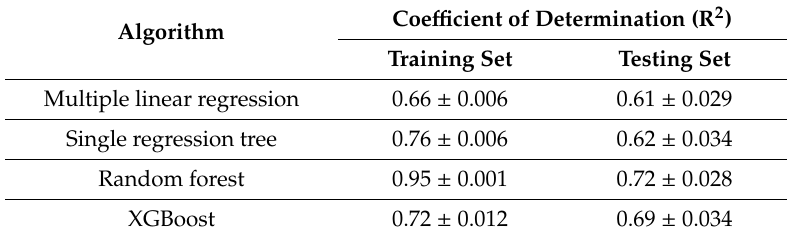
Table 7. R 2 (mean ± standard deviation) of annual EUI for training and testing sets of di ff erent